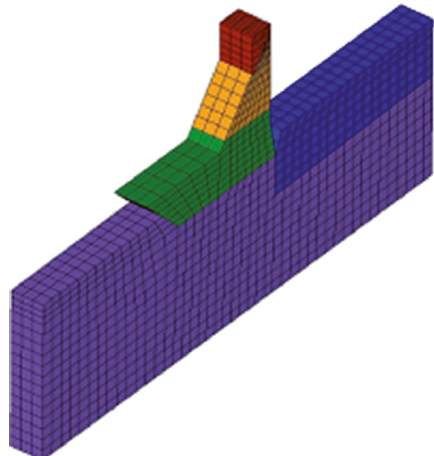
Figure 4: The finite element mesh for the #7 left-bank water- retaining dam section.